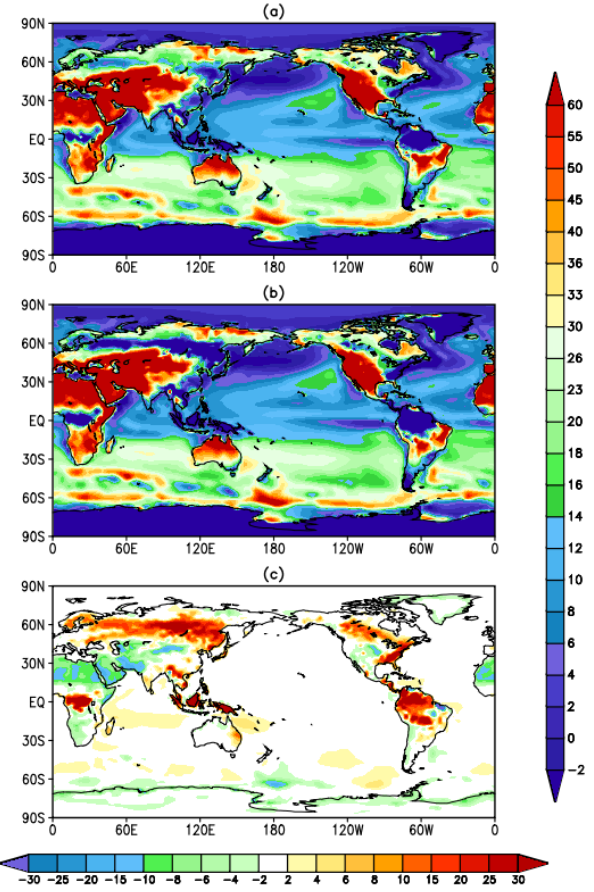
Figure 6. June-July-August-averaged sensible heat flux in Wm − 2 from (a) experiment 3 (Louis surface layer scheme), (b) experiment 2 (Helfand scheme) and (c) the difference of experiment 3 minus experiment 2.